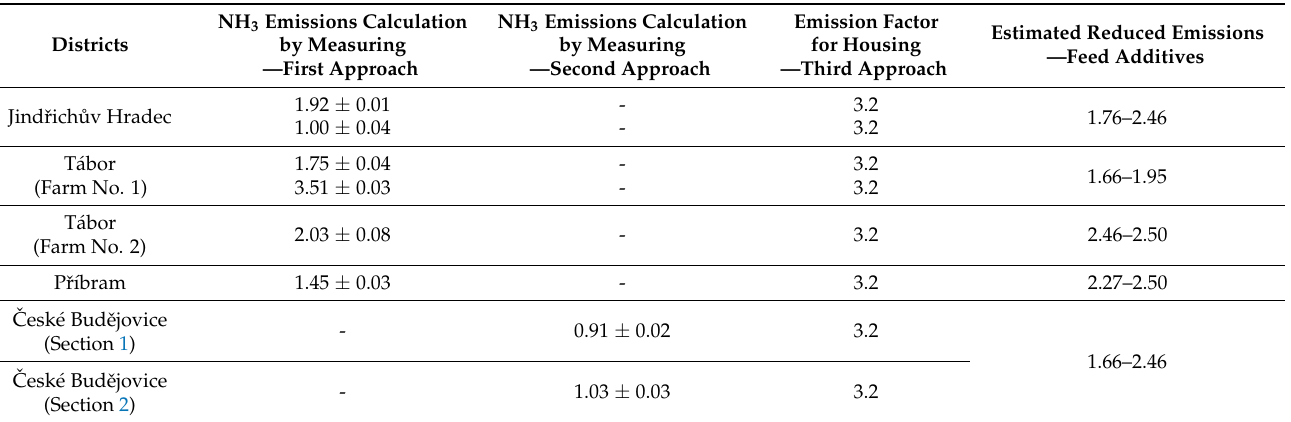
Table 7. Determination of NH 3 emissions (kg NH 3 · animal − 1 · year − 1 ) calculation by measuring in comparison with estimation by emission